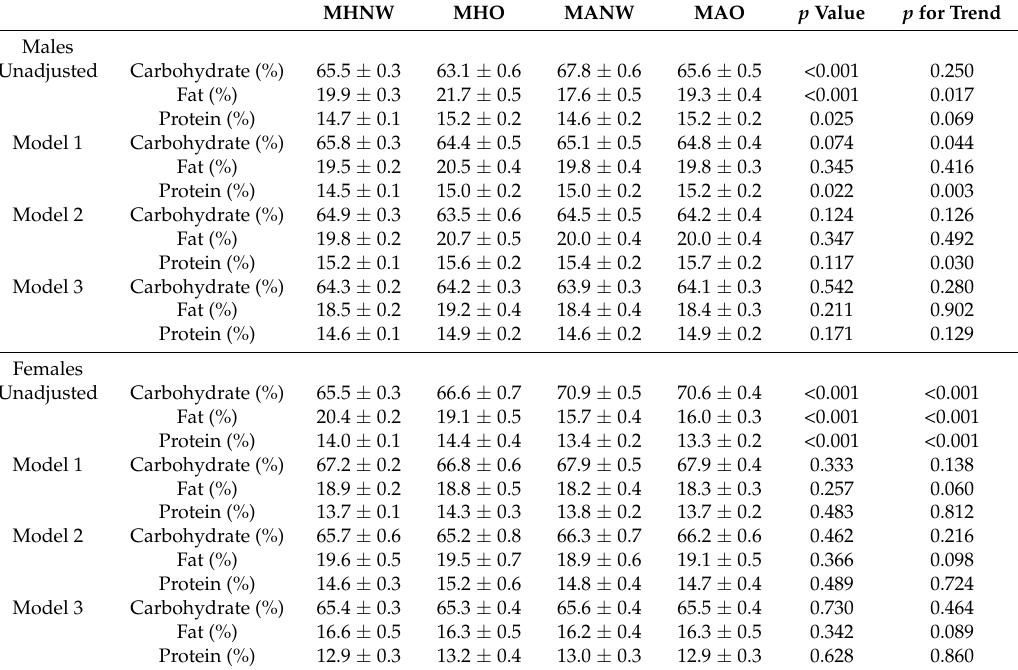
Table 2. Mean proportions of macronutrient intakes by obesity/metabolic risk phenotypes.